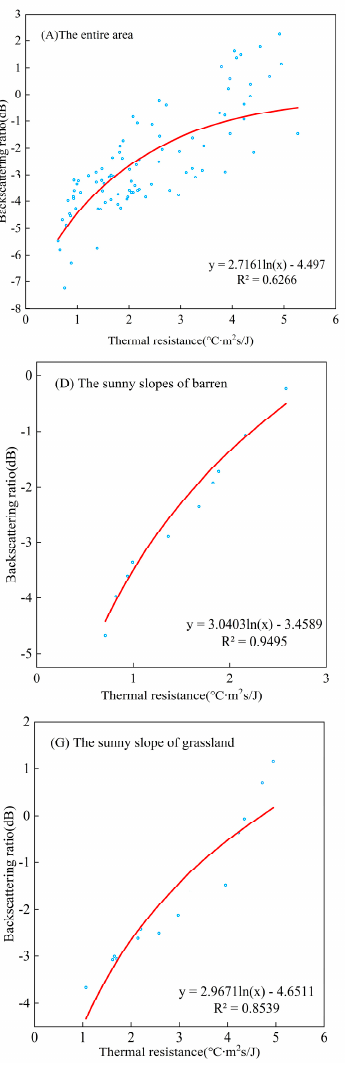
Figure 3. ( A ) shows the fit of snow thermal resistance to backscattering coefficient ratio for all unclassified observations; ( B – G ) shows the fit of snow thermal resistance to backscattering coefficient ratio for each class after classification.